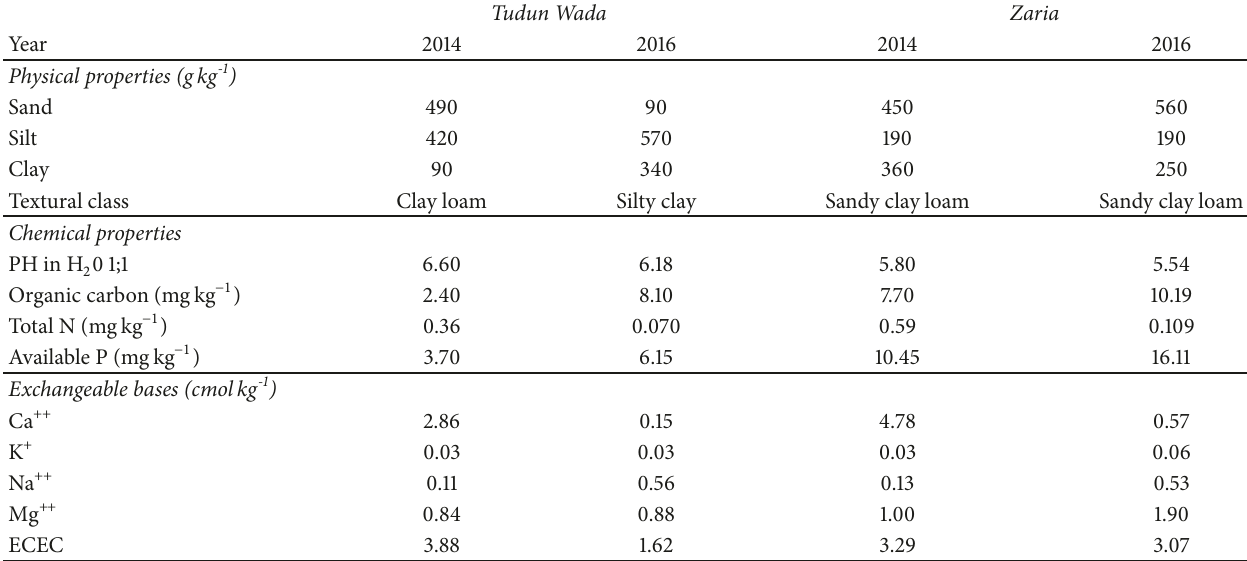
Table 3: Physical and chemical properties of soil at Tudun Wada and Zaria during 2014 and 2016 rainy